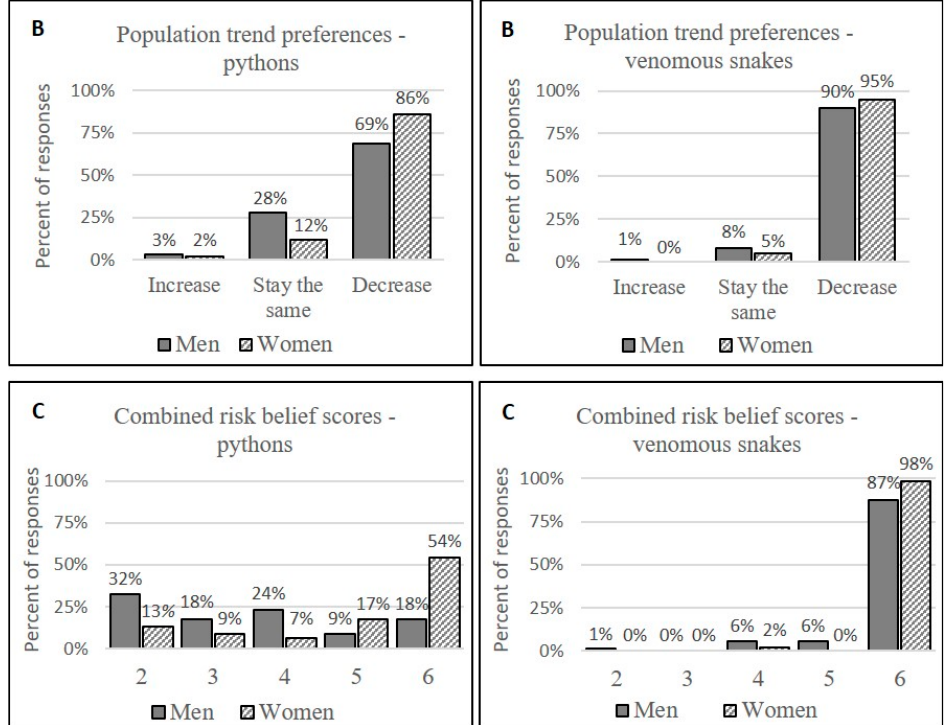
Figure 3. Attitudes towards snakes based on the responses of male and female survey participants ( n = 71, men; n = 56, women) in Banten, Indonesia: ( A ) Feelings when seeing a python/venomous snake; ( B ) Preferred populations trends for pythons/venomous snakes in neighborhood areas; ( C ) Combined risk belief scores, consisting of coded answers to the questions “How dangerous do you believe pythons/venomous snakes are to people? ” and “How afraid are you of pythons/venomous snakes?”, where 2 corresponds to a “not dangerous” (score of 1) plus “not afraid” (score of 1) response, and 6 corresponds to a “very dangerous” (score of 3) plus ”very afraid” (score of 3) response. Risk beliefs toward venomous snakes did not differ significantly between men and women; all but 2 of the 127 survey participants (98%) believed venomous snakes to be “very dangerous” and 91% ( n = 116) considered themselves “very afraid” of venomous snakes.